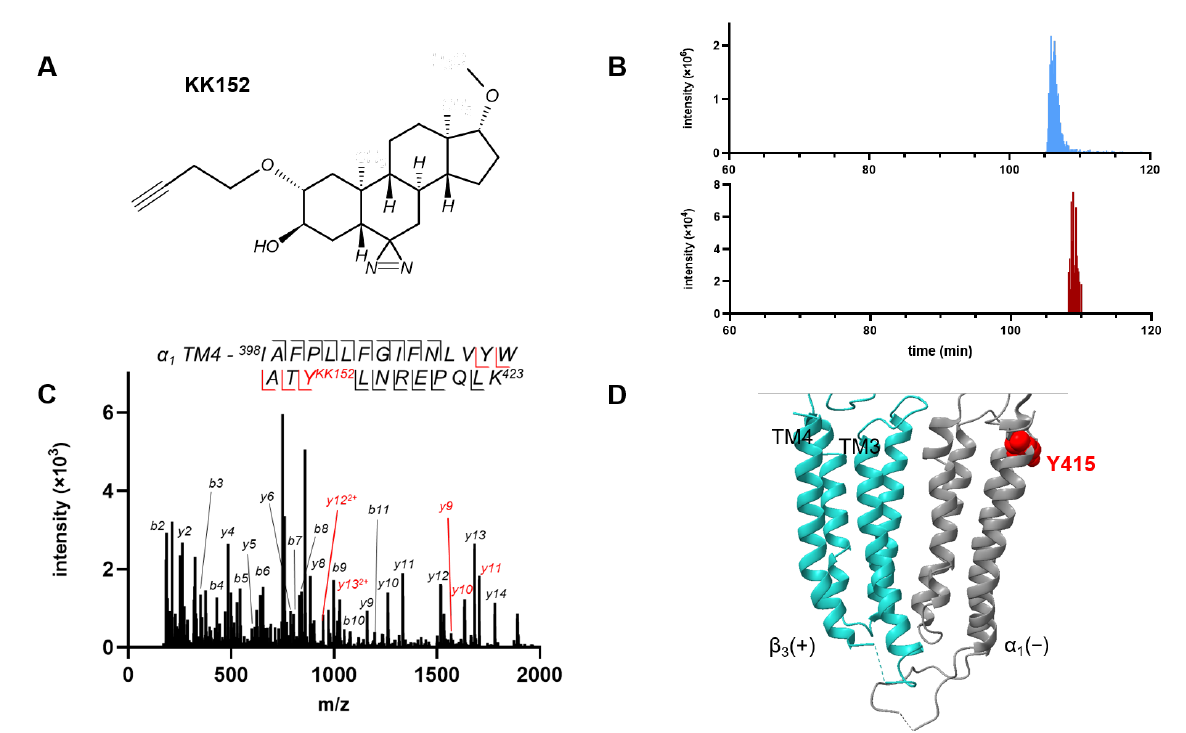
Figure 4. Photolabeling of α 1 β 3 GABA A receptors by KK152 (the enantiomer of KK123). ( A ) The structure of KK152. ( B ) Extracted ion chromatograms from mass spectrometric analysis illustrating the labeling of α 1 -TM4 peptide in α 1 β 3 GABA A receptors by KK152. The y-axis shows the intensity of the unlabeled TM4 peptide (top panel) and the KK152-labeled TM4 peptide (bottom panel). The x-axis shows the chromatographic retention time of the unlabeled TM4 peptide (blue, 105.9 min) and the KK152-labeled TM4 peptide (red, 108.5 min) illustrating that the increased hydrophobicity of the labeled peptide lengthens retention time on reversed phase chromatography. ( C ) HCD fragmentation spectrum of the α 1 subunit TM4 tryptic peptide photolabeled by 30 μM KK152. Red and black indicate fragment ions that do or do not contain KK152, respectively. The peptide sequence shows that the y-ion series of fragment ions contains diagnostic peptides indicating labeling of residue α 1 (Y415). ( D ) Structure of the α 1 β 3 GABA A receptor showing the location of Y415, the residue labeled by KK152 at the exoplasmic end of α 1 TM4. The α 1 subunit is shown in grey and the β 3 subunit in turquoise.